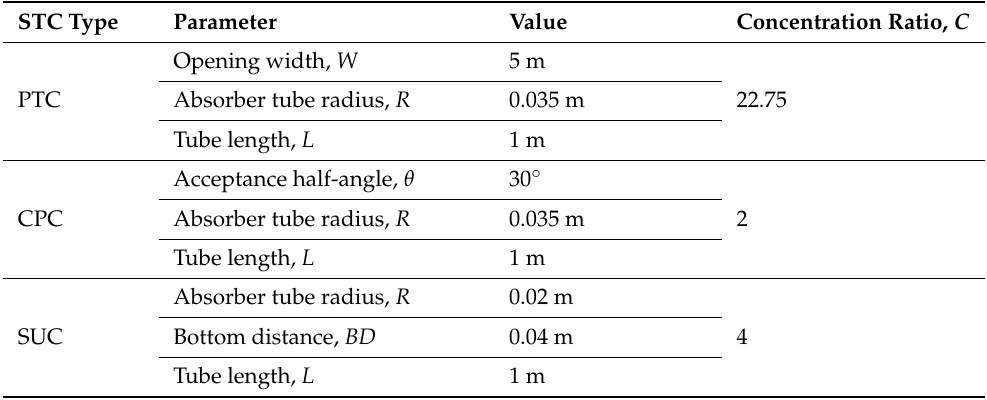
Table 1. Geometrical parameters of the